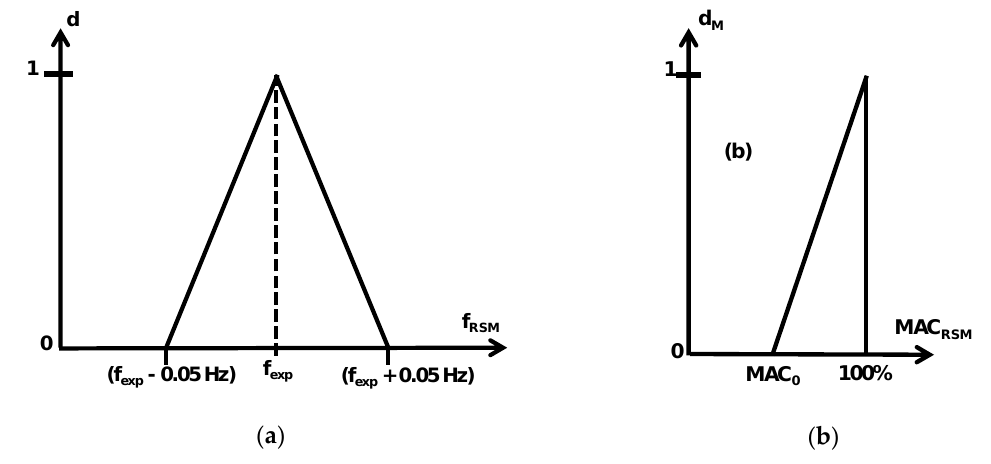
Figure 9. Desirability functions for natural frequencies ( a ) and MAC values ( b ).